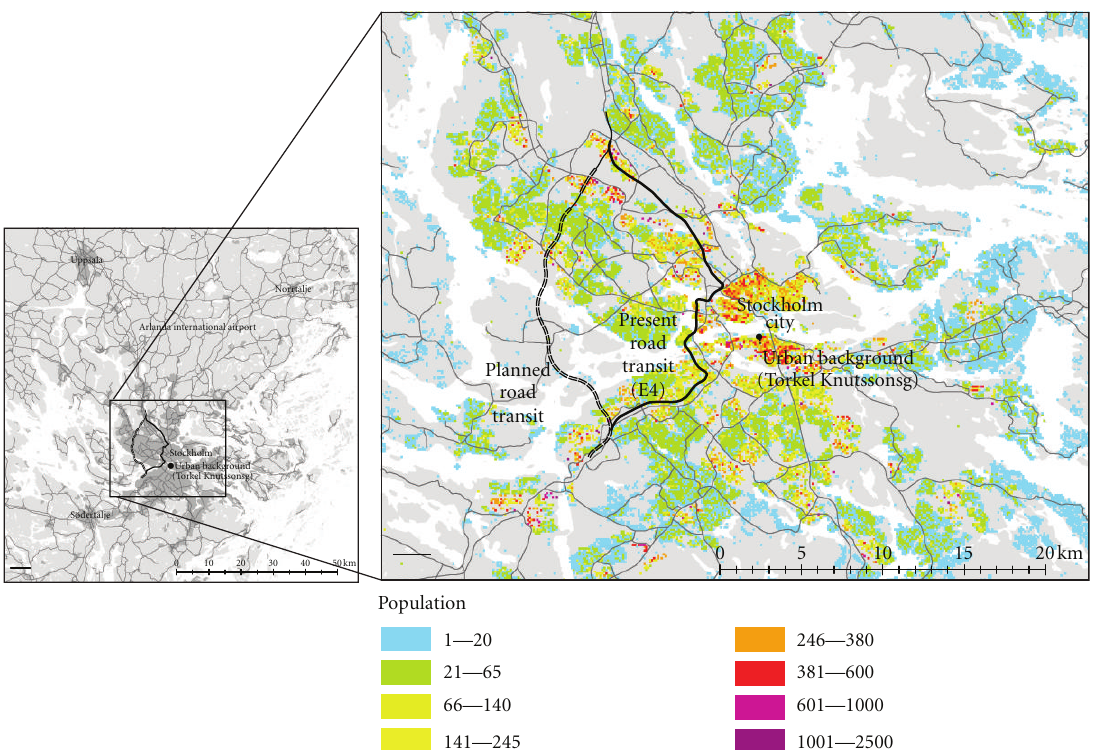
Figure 3: Map showing the air quality downscaling modeling domain (102 × 102km 2 , left) and the local domain (36 × 30km 2 , right) used for population exposure assessment. The locations of present and planned road transit are indicated with solid and broken lines, respectively. The location of the urban background monitoring station is indicated with a filled circle. The colors indicate population density (number of people in 100 × 100 m 2 squares). Thin black lines are roads. White and grey areas indicate water and